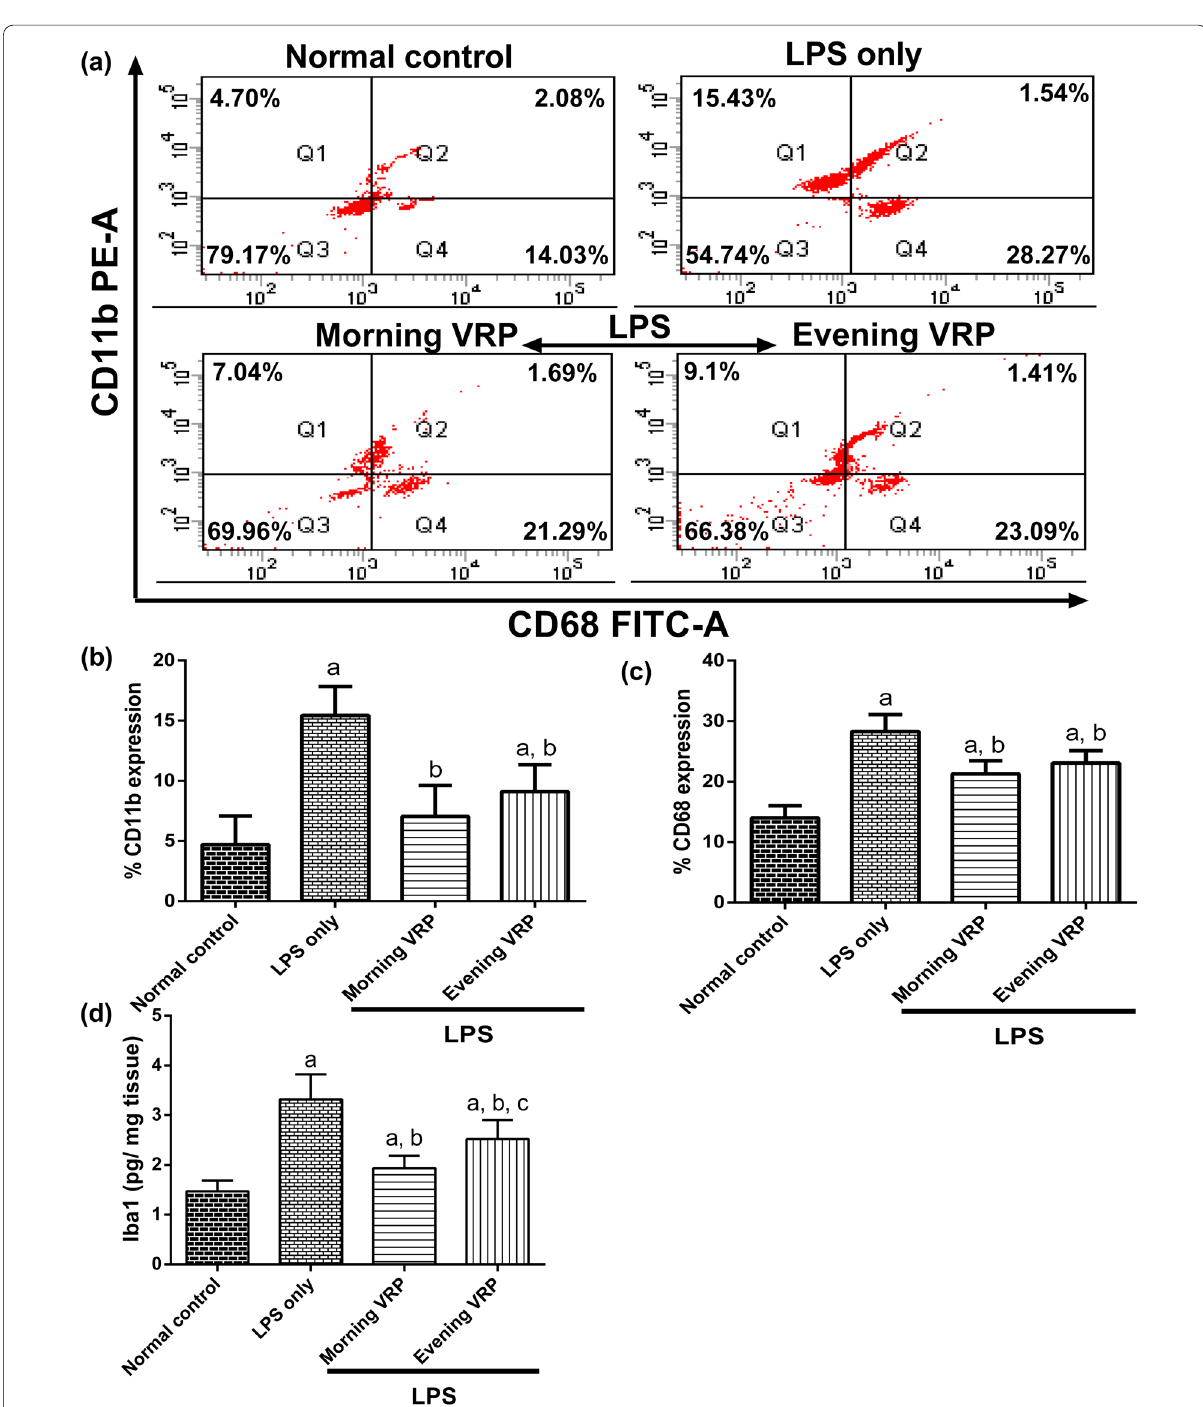
Fig. 4 Effect of VRP on microglia-activation markers. a Dot plot flow cytometric analysis for one representative sample for each studied group, b Column chart for CD11b + cells, c Column chart for CD68 + cells, and d Concentration of Iba1. For b, c , and d charts, data are expressed as the mean SD and were analyzed using one-way ANOVA followed by Tukey post hoc test. Values were considered significantly different at P < 0.05. a: ± significant versus normal control and b: significant versus LPS only, and c: significant versus morning VRP. LPS: lipopolysaccharides, VRP: verapamil, Iba1: Iba1: ionized calcium-binding adapter molecule